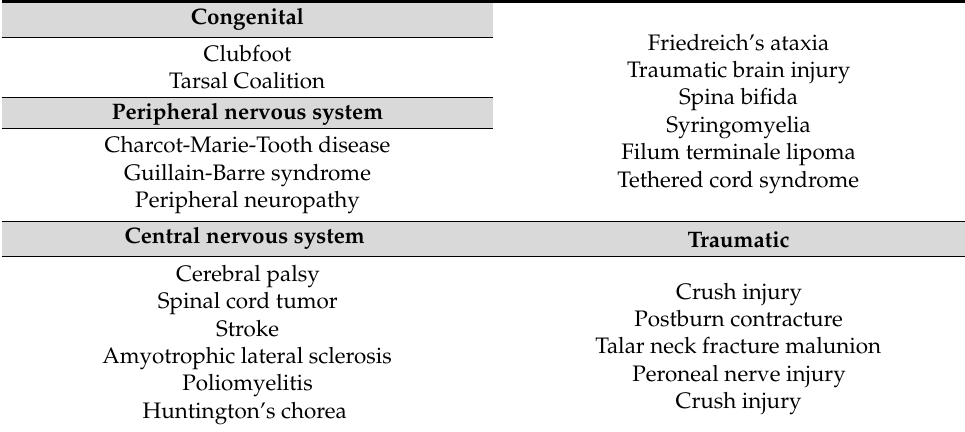
Table 1. Differential etiology of cavus foot deformity.